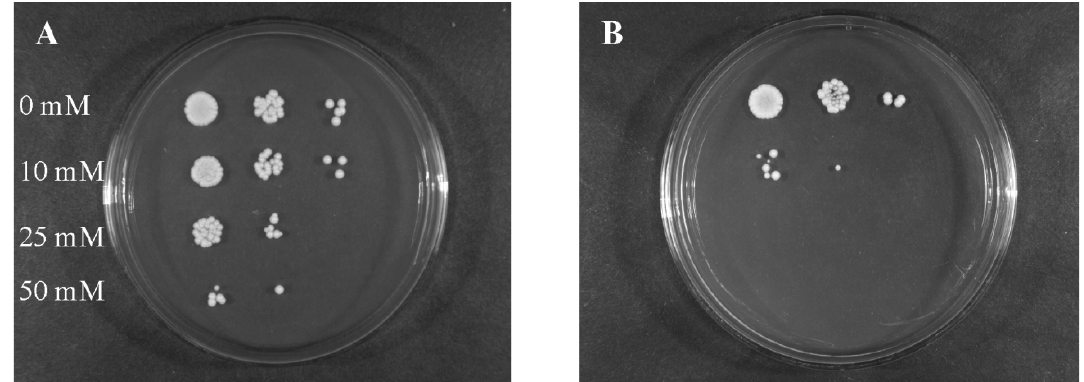
Figure 1. The oxidative stress tolerance assay of C. albicans ATCC 10231 pre-cultured for 24 h at 35 °C on control SDA ( A ) or on SDA + T. alexandrinum SAPF (0.5 mg/mL); ( B ) The inocula of yeasts prepared in this way, were further incubated with different concentrations of hydrogen peroxide for 1 h at room temperature, diluted (10 5 to 10 3 cells/mL) and spotted (5 μ L) on YPG plates. Intensity of growth (micro- and macrocolony morphology) was evaluated after the following 48 h of incubation at 30 °C. Four independent experiments were performed. In Figure 1, the representative data are shown.